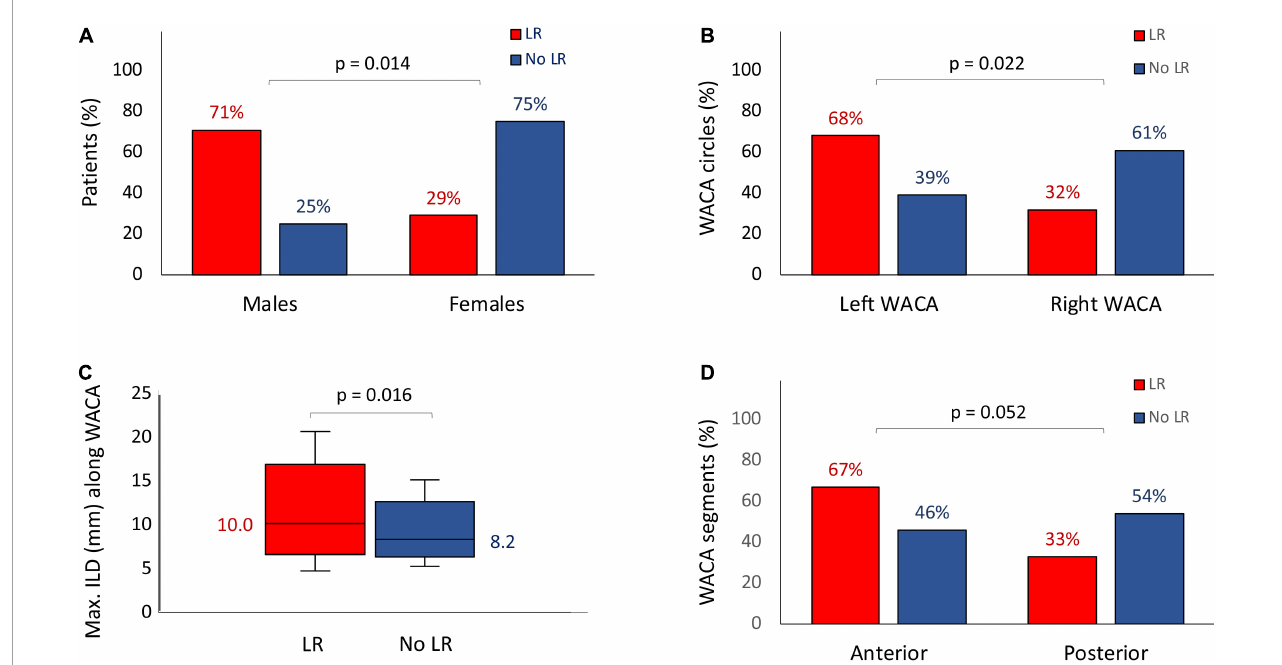
FIGURE3 Risk factors for the late WACA circle/segment reconnection: the male gender (A) , the left-sided location of WACA circle (B) , the maximum ILD along WACA circle (C) and the anterior segment of WACA (D) . All abbreviations as in previous